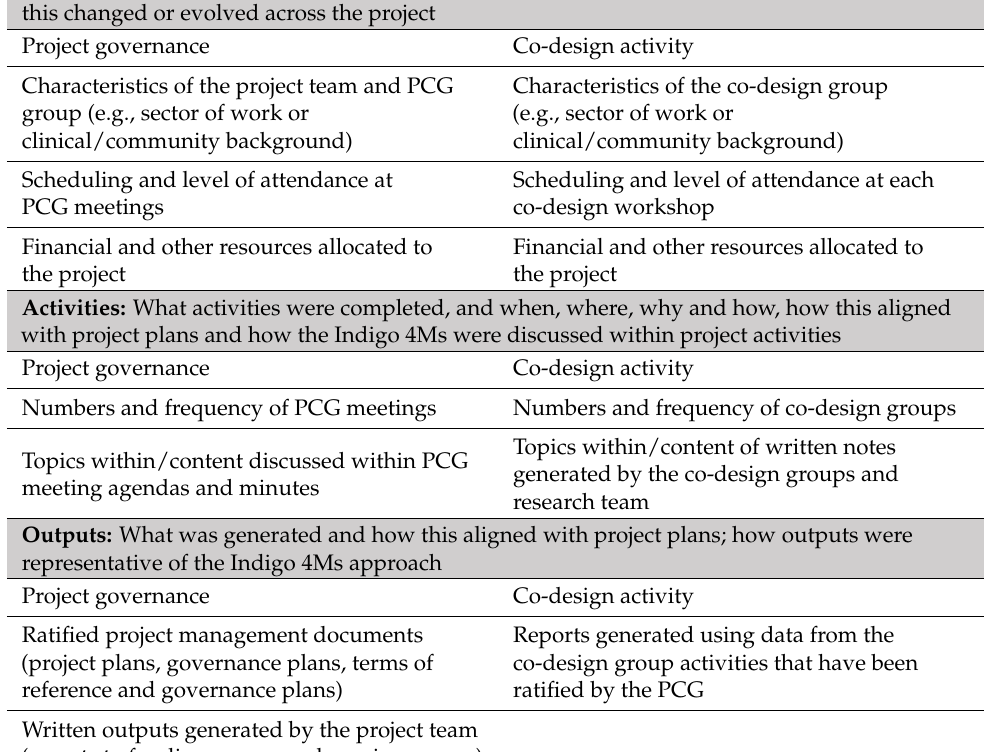
Table 1. Process Table 1. Process evaluation.